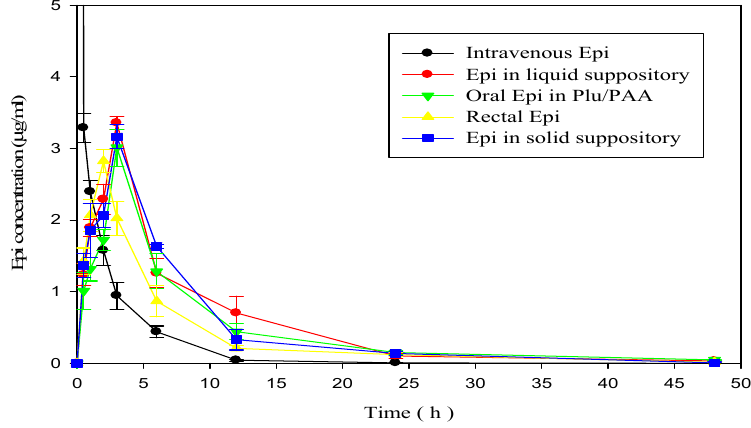
Figure 6. Plasma concentration-time curve of Epi sampled from SD rats after intravenous administration of Epi (50 μ g/mL) solution, rectal administration of Epi solution, oral and rectal administration of Epi in Plu 14%/PAA 0.75% liquid or solid suppositories, respectively. Data are means ± SD of six experiments.